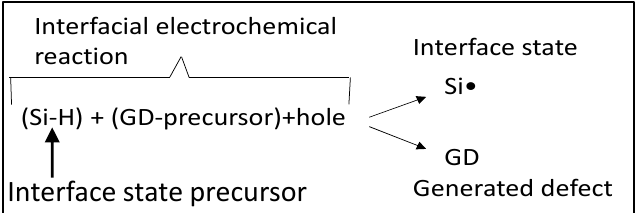
Figure 32. The speculated electrochemical reaction for NBTI. ‘ ● ’ represents a valence electron [17].